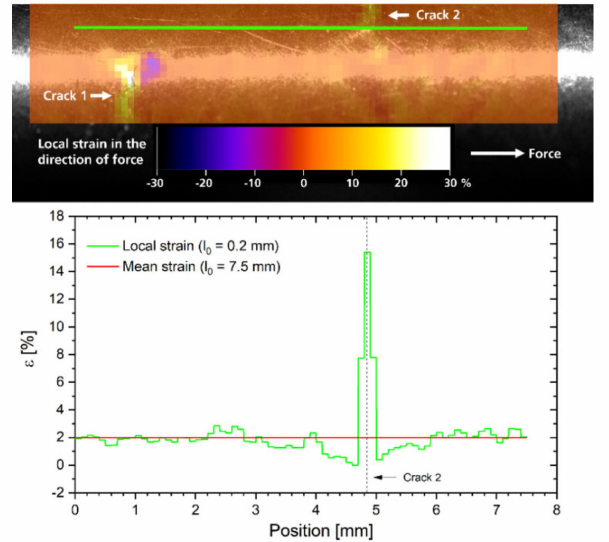
Figure 9. Real-time strain-field measurement where the local displacement is superimposed by color to the camera image ( top ). Bottom : The green line shows local displacement with l 0 = 0.2 mm with a clear peak at crack 2. For strain-control, mean strain with l 0 = 7.5 mm of the green line is measured between the ends (red line in bottom